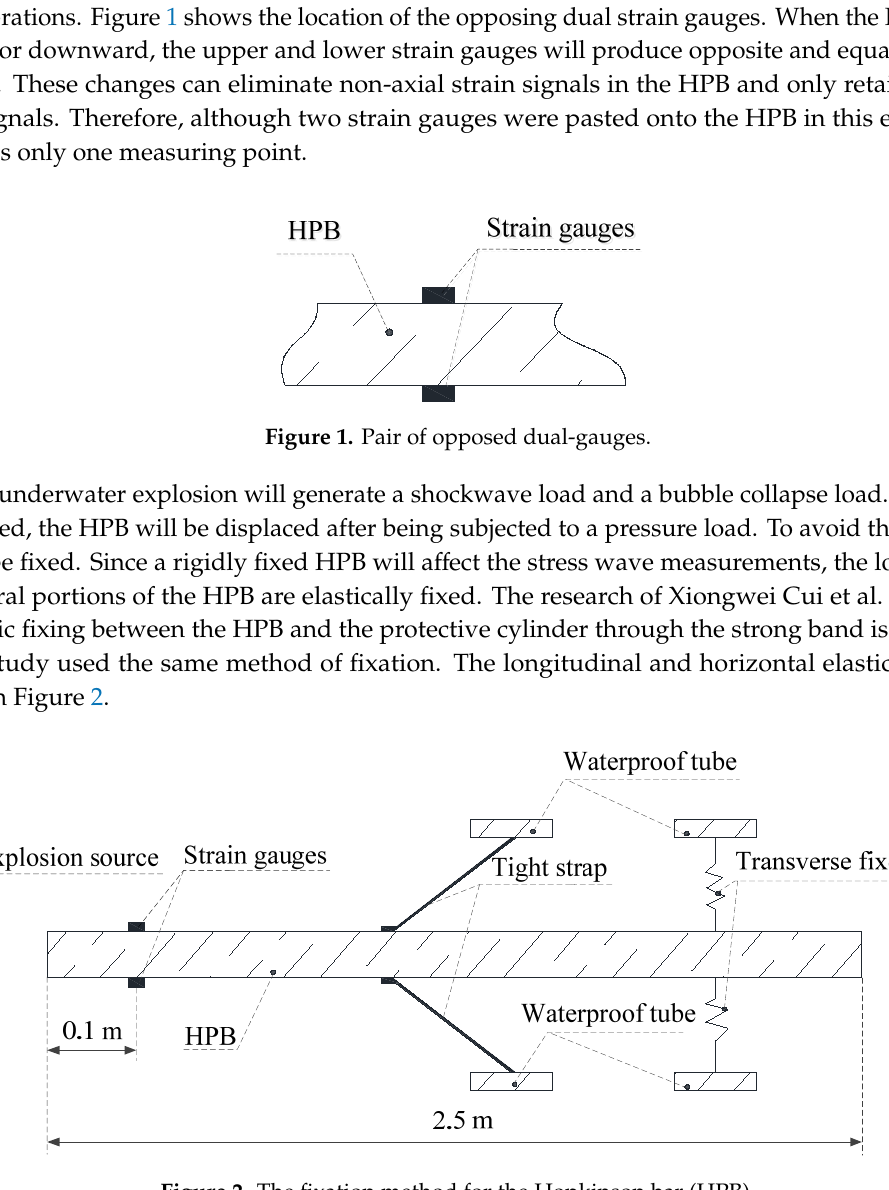
Figure 2. The fixation method for the Hopkinson bar (HPB).